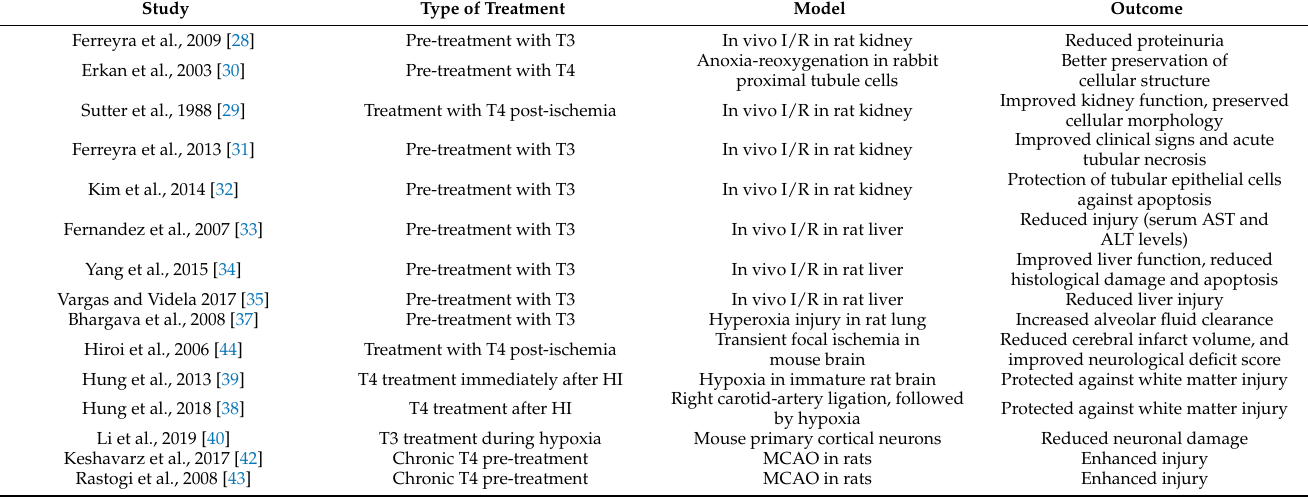
Table 2. Accumulating experimental evidence shows that thyroid hormone plays a critical role in adaptation of the kidney, liver, lungs, and brain to hypoxic/ischemic injury (I/R: Ischemia/Reperfusion, MCAO: Middle Cerebral Artery Occlusion, HI: Hypoxic